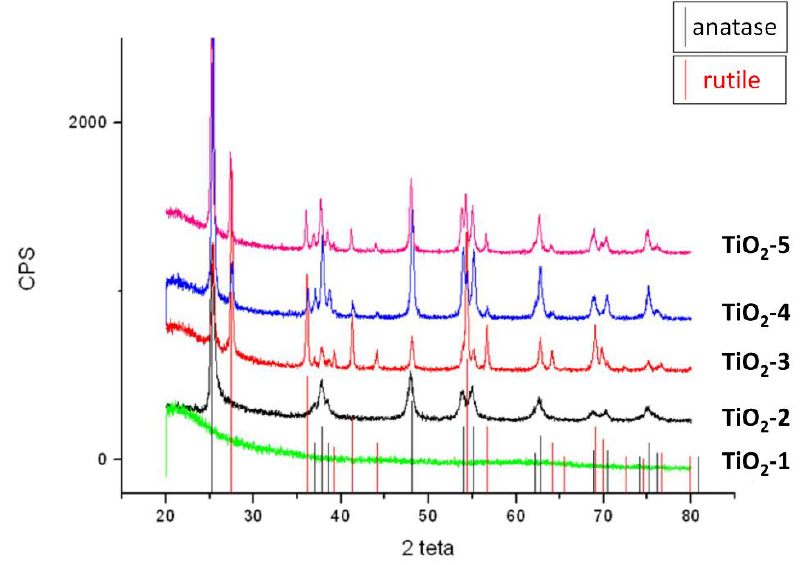
Figure 3. XRD of the TiO 2 -1 treated at 60 °C-72 h; TiO 2 -2 treated from 25 °C to 400 °C-2 h at 9 °C/min; TiO 2 -3 treated from 25 °C to 600 °C-2 h at 9 °C/min; TiO 2 -4 treated at 600 °C-1 h; TiO 2 -5 wet precipitates treated at 600 °C-1 h.